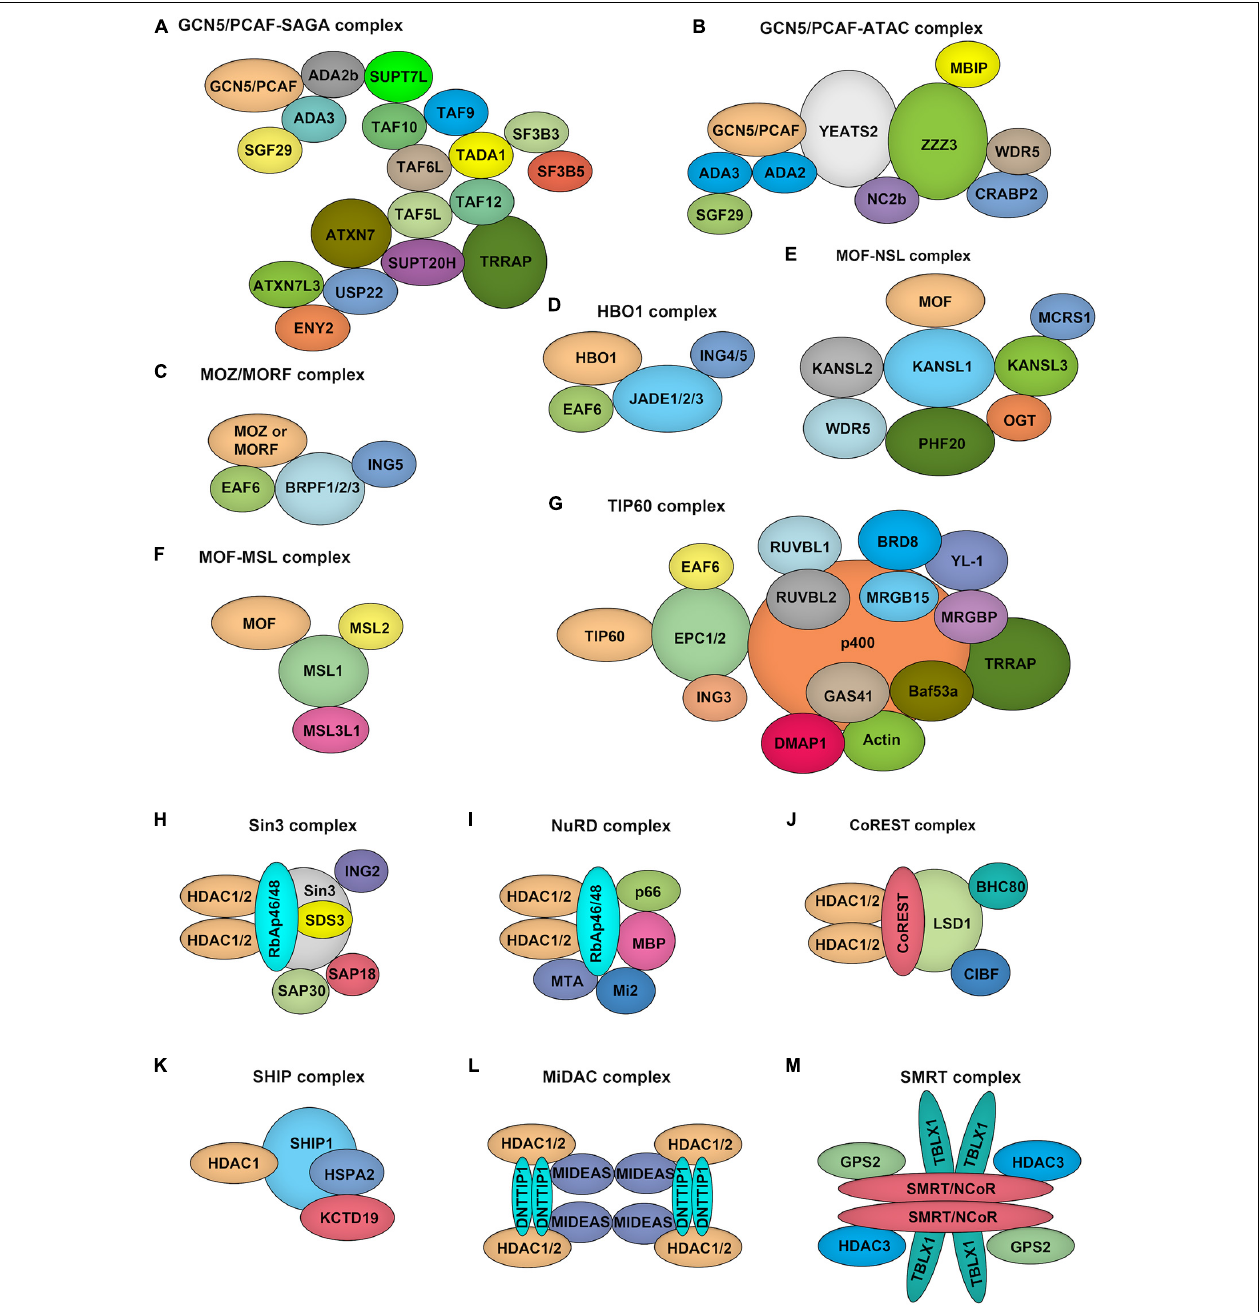
FIGURE 3 | Composition of HATs and HDACs containing multiprotein complexes. (A–G) . Depiction of the major histone acetyltransferase complexes: GCN5/PCAF-SAGA (A) and GCN5/PCAF-ATAC (B) , MOZ/MORF-ING5 (C) , HBO1-JADE (D) , MOF-NSL (E) , MOF-MSL (F) , TIP60 (G) , which contains two HATs. (H–M) , Overview of class I HDAC containing complexes. Sin3 complex (H) : The Sin3 complex is comprised of HDAC1 and HDAC2, delivering enzymatic activity and the structural components Sin3, RbAp46, RbAp48, SAP18, SAP30, and SDS3. NuRD complex (I) : RbAp46, RbAp48, HDAC1, and HDAC2 are also found in the NuRD complex, together with the NuRD specific factors MTA, Mi-2, p66, and MBD. CoREST complex (J) : The CoREST complex consists of CoREST, CIBF, BHC80, HDAC1, HDAC2 and is targeted to DNA via the REST protein. SHIP complex (K) : The SHIP complex was identified recently as a testis specific complex containing SHIP1, HDAC1, HSPA2, and KCTD19. MiDAC complex (L) : The mitotic deacetylase complex (MiDAC) is a recently identified histone deacetylase (HDAC) complex using proteomics in cells that are blocked in mitosis by nocodazole. MiDAC contains HDAC1/2, a protein called DNTTIP1 (deoxynucleotidyltransferase terminal-interacting protein 1), and the MIDEAS (mitotic deacetylase-associated SANT domain protein) co-repressor protein. SMRT/NCoR complex (M) : The core of the complex consists of SMRT/NCoR bound to TBL1 (transducin beta-like protein 1), GPS2 (G protein pathway suppressor 2), and HDAC3 proteins.